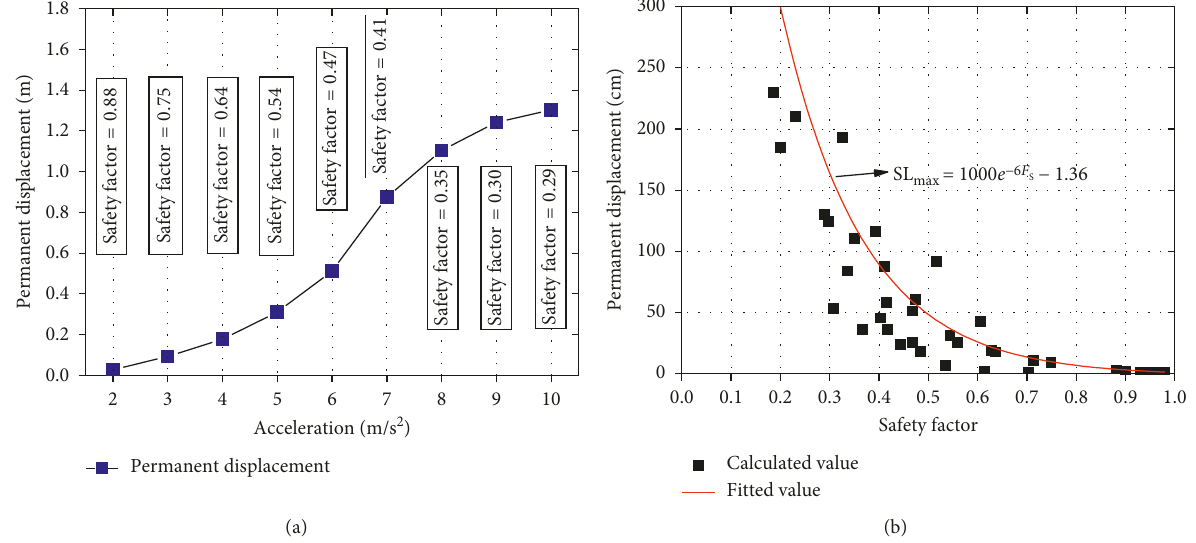
Figure 8: (a) Relationship of the safety factor and the peak acceleration. (b) Fitting relationship of the permanent displacement and safety factor.